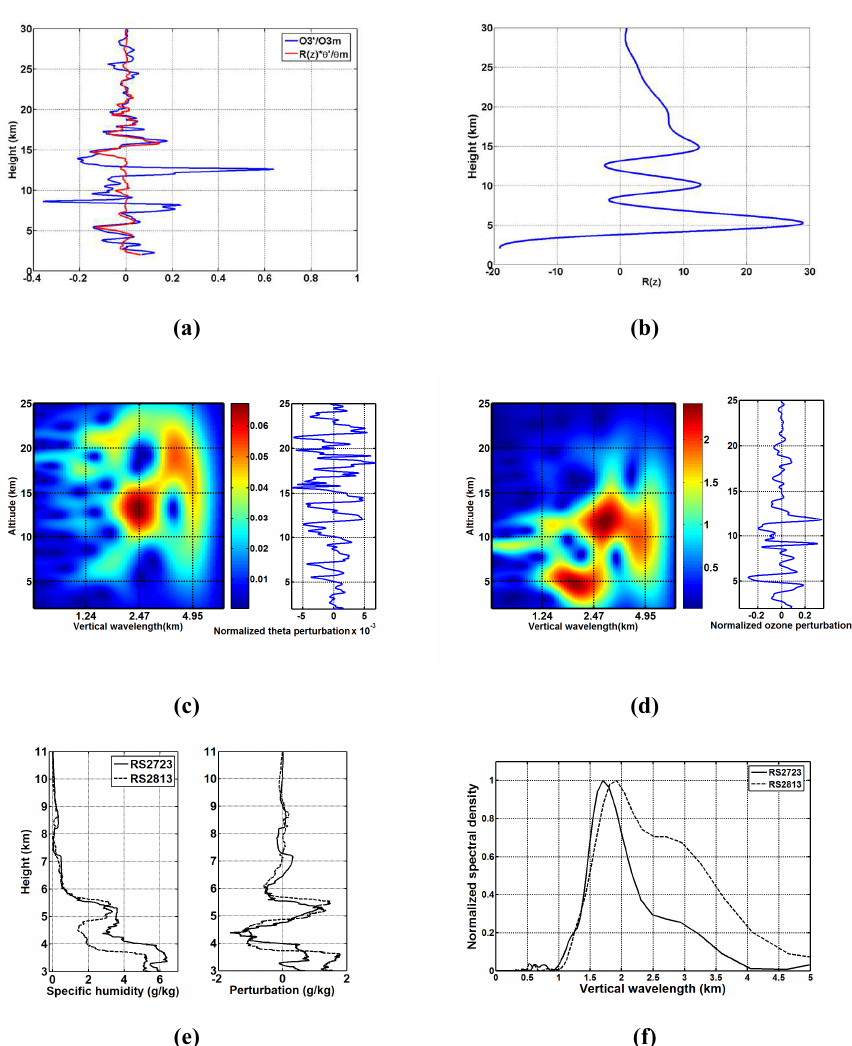
Figure 10. (a) Normalised perturbations of the temperature and the ozone mixing ratio for the vertical wavelength bandwidth of 1.2–4.8km using DWT. Temperature perturbation ( ◦ C) profile has been multiplied by the factor R(z) (b) defined in Sect. 3.6. (c) and (d) Morlet CWT (left panels) of normalised temperature and ozone concentration (ppmv) perturbations (right panels) on 28 July at 13:30UTC (colour scale: red relatively high values, blue relatively low values). (e) Specific humidity (gkg − 1 ) and perturbations on 27 July at 23:03UTC and 28 July at 13:30UTC at heights of 3–11km on left and right panels respectively, and (f) corresponding normalised spectral density of specific